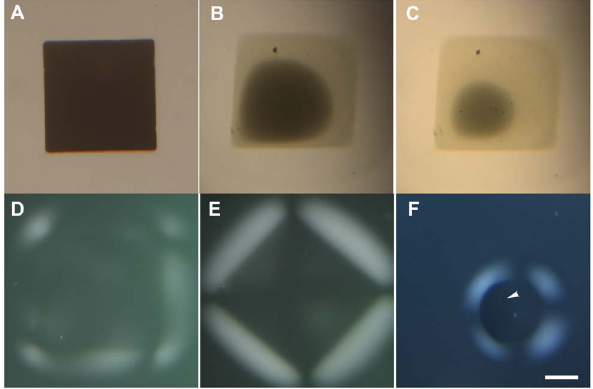
Figure 6. Growth of the gel phase around copper pads on a ITO substrate immersed in a drop of 0.5wt% CNCs in water and held at 1 V. A) square of copper before the experiment. B) Square of copper after 27 min. C) square of copper after 28 min. D) square of copper after 32 min imaged with crossed polarizers. E) Same as D) but the square was rotated by 45 u . F) disk of copper after 7 min, the copper is still visible on the left side of the disk, arrowhead. The position of the crossed polarizers is drawn in Figure 1 panel A. The scale bar is 300 m